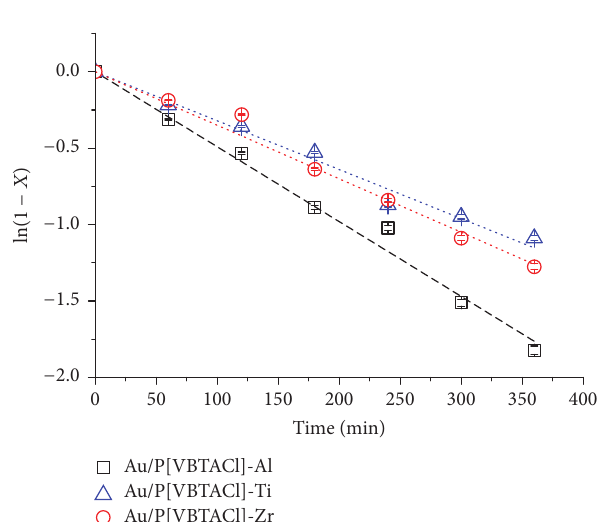
Figure 4: Activity curves based on p-CNB conversion for all the synthesized catalysts. Dash line: pseudo-first kinetic model. Reac- tion conditions: CNB concentration: 0.02 molL −1 , catalyst mass: 0.050 g, P : 20 bar, mixing speed: 800rpm, and solvent: absolute H 2 ethanol.